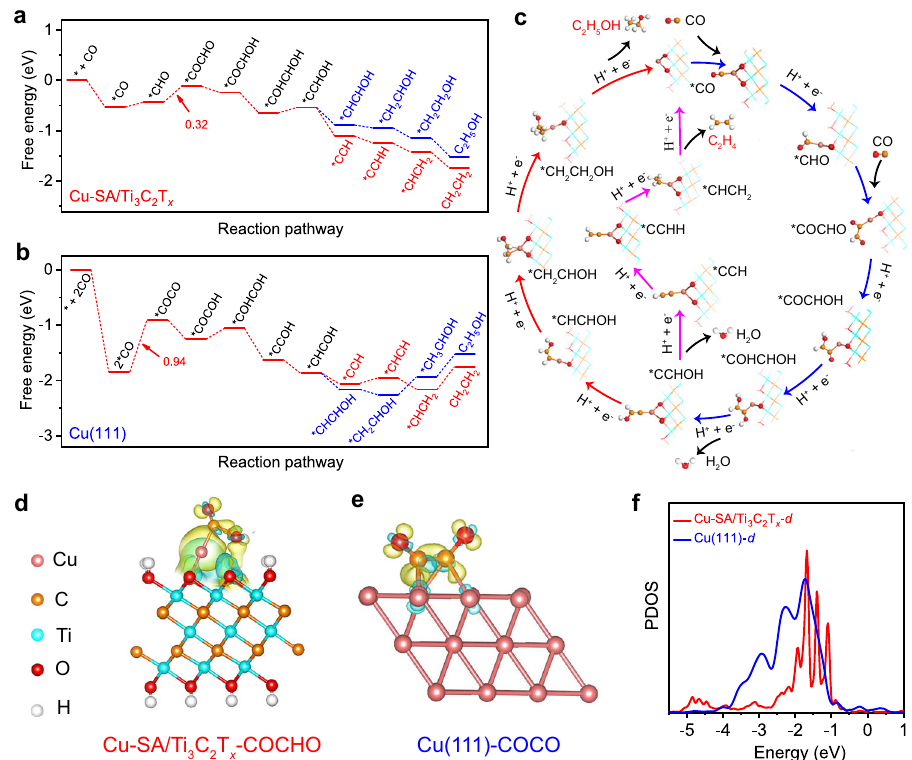
Fig. 3 The optimized energy pathway for CO reduction toward C 2 H 4 and EtOH on Cu-SA/Ti 3 C 2 T x . a , b Free energy diagrams of CO reduction over a Cu- SA/Ti 3 C 2 T x and b Cu (111). The reason for choosing Cu (111) is that Supplementary Fig. 27 indicates the preferential orientation of the Cu nanoparticles in Cu-NP/Ti 3 C 2 T x is <111>. c Schematic representation of CO reduction reaction pathways. In some adsorption con fi gurations, Cu – O bond was elongated to get the lowest energy state. d , e Charge density difference of the *COCHO-adsorbed and *COCO-adsorbed con fi guration in d Cu-SA/Ti 3 C 2 T x and e Cu (111), respectively. f The projected densities of states (PDOS) of d -orbitals in Cu-SA/Ti 3 C 2 T x and Cu (111) with an aligned Fermi level. Yellow and blue shadows represent charge accumulation and depletion in the space, respectively; the pinkish-orange, blue, dark yellow, red, and white spheres represent Cu, Ti, C, O, and H,